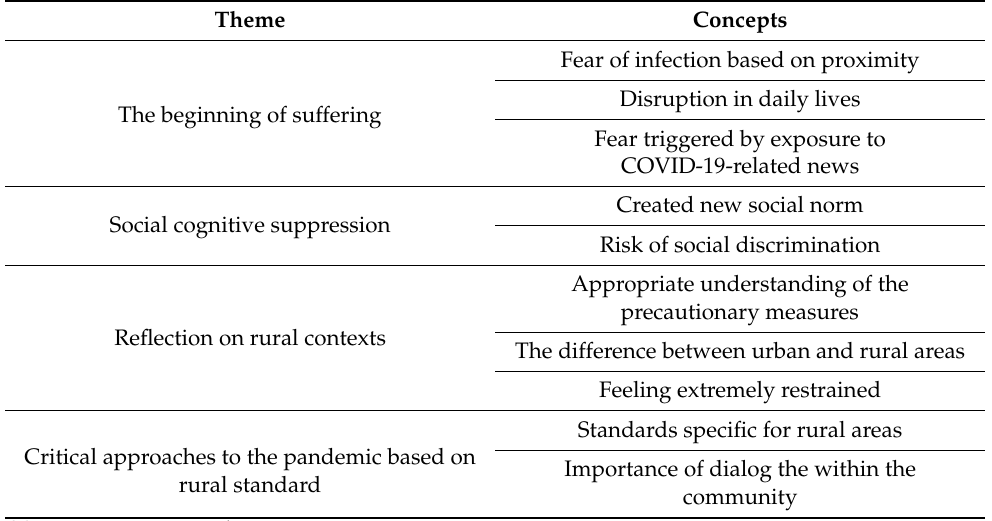
Table 1. Themes and concepts regarding rural older people’s perception of the conditions during the COVID-19